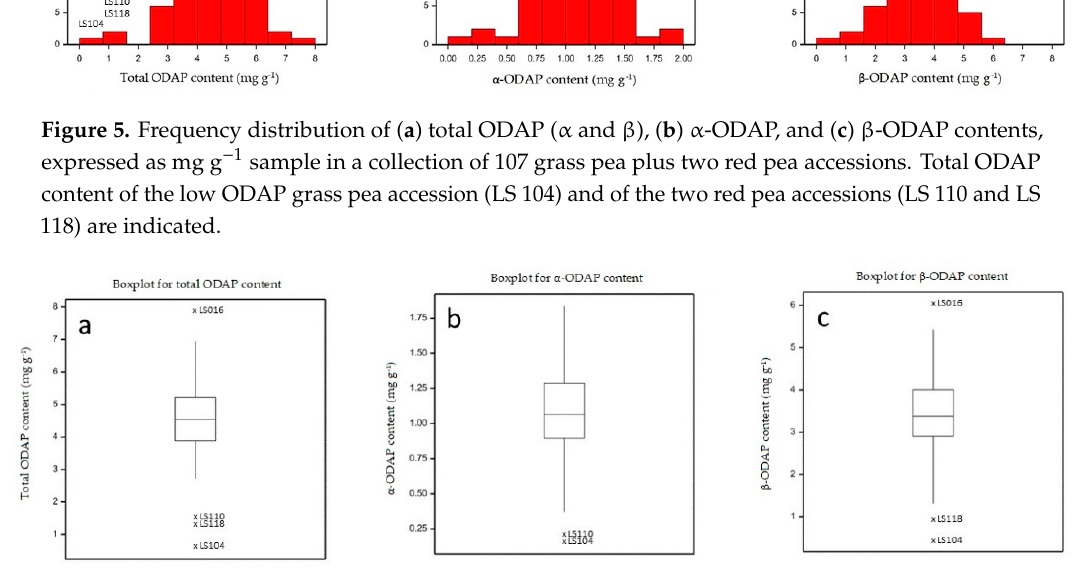
Figure 6. Boxplot distribution of ( a ) total ODAP ( α and β ), ( b ) α -ODAP, and ( c ) β -ODAP contents, expressed as mg g − 1 sample in a collection of 107 grass pea plus two red pea accessions.